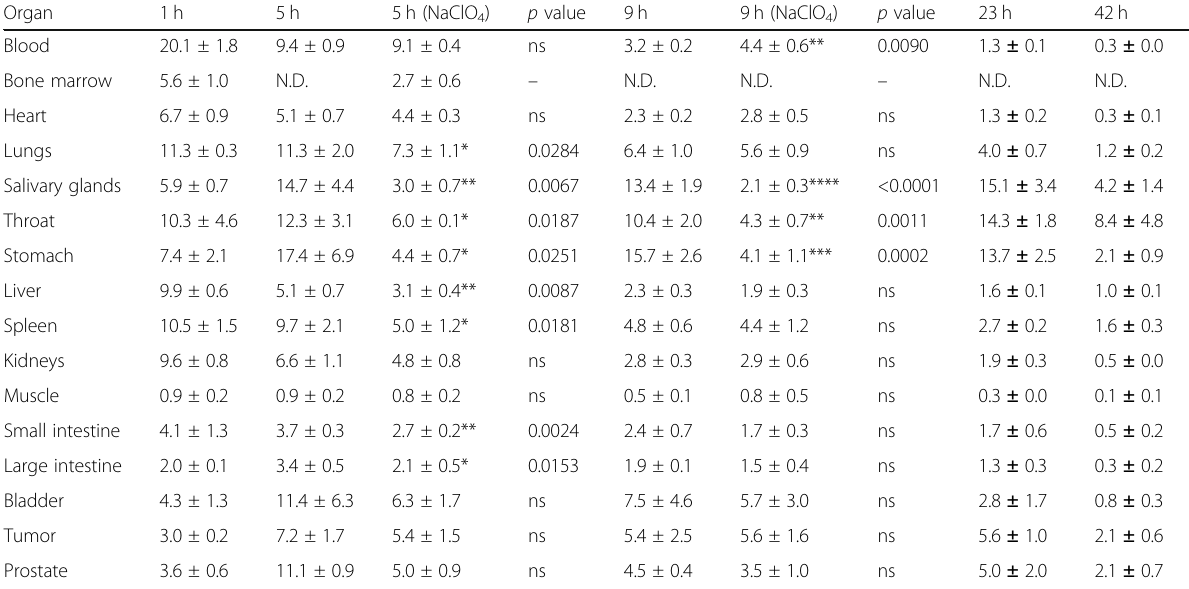
Table 1 Biodistribution with 211 At-A11 minibody